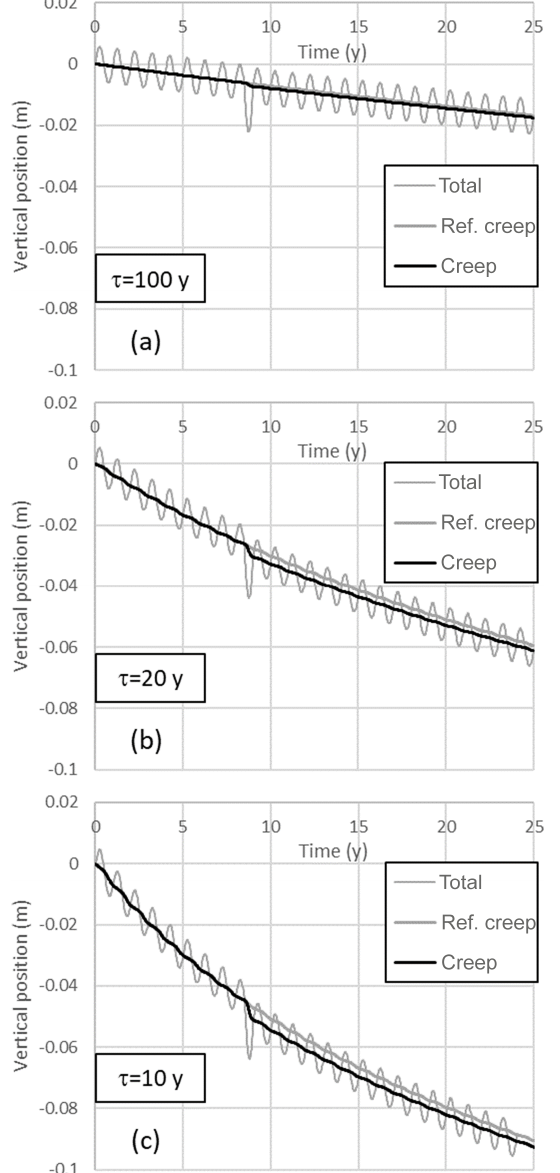
Figure 3. Calculated subsidence for scenario “dry summer”. The creep of the reference runs is depicted as “ref.